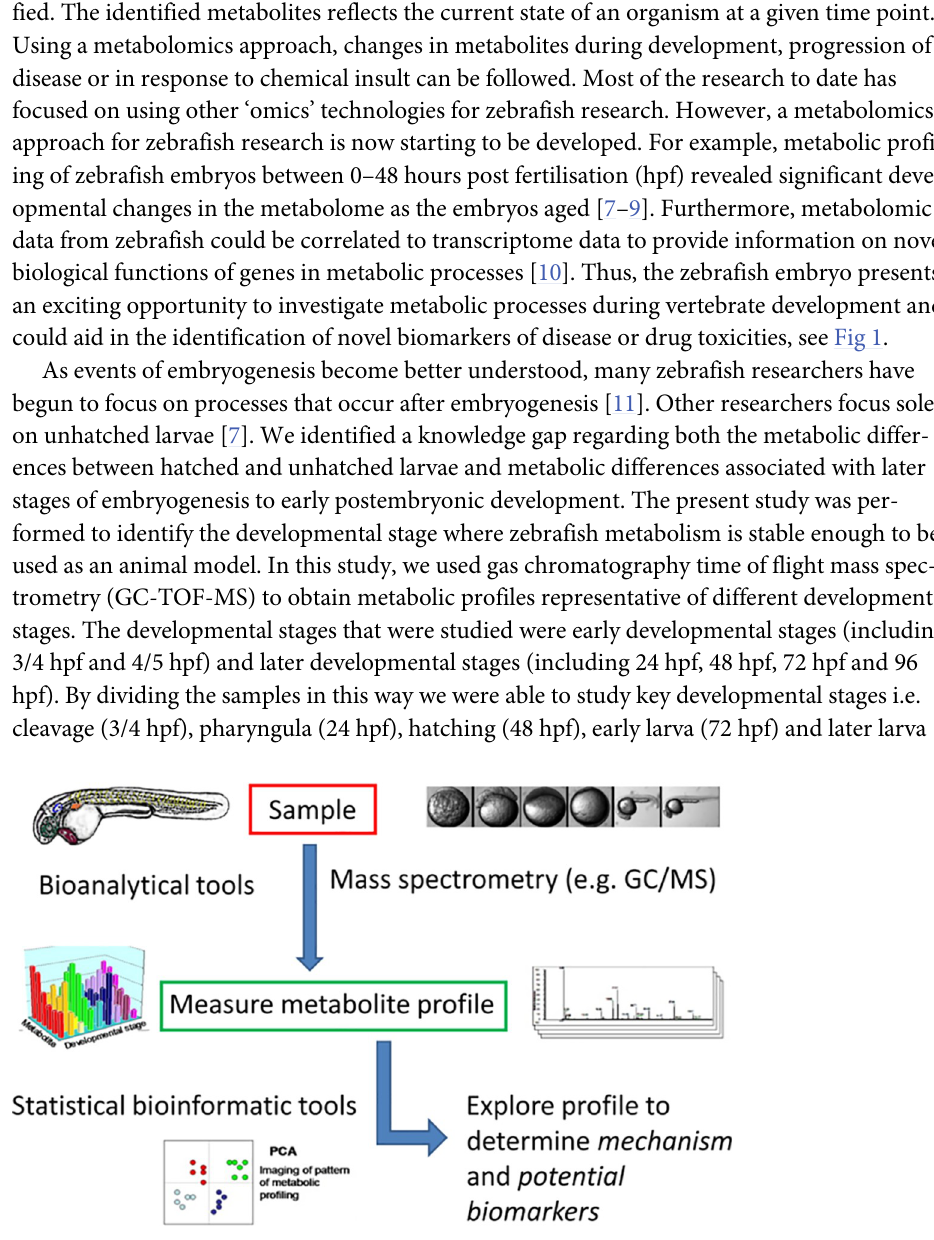
Fig 1. Process for metabolic profiling of zebrafish